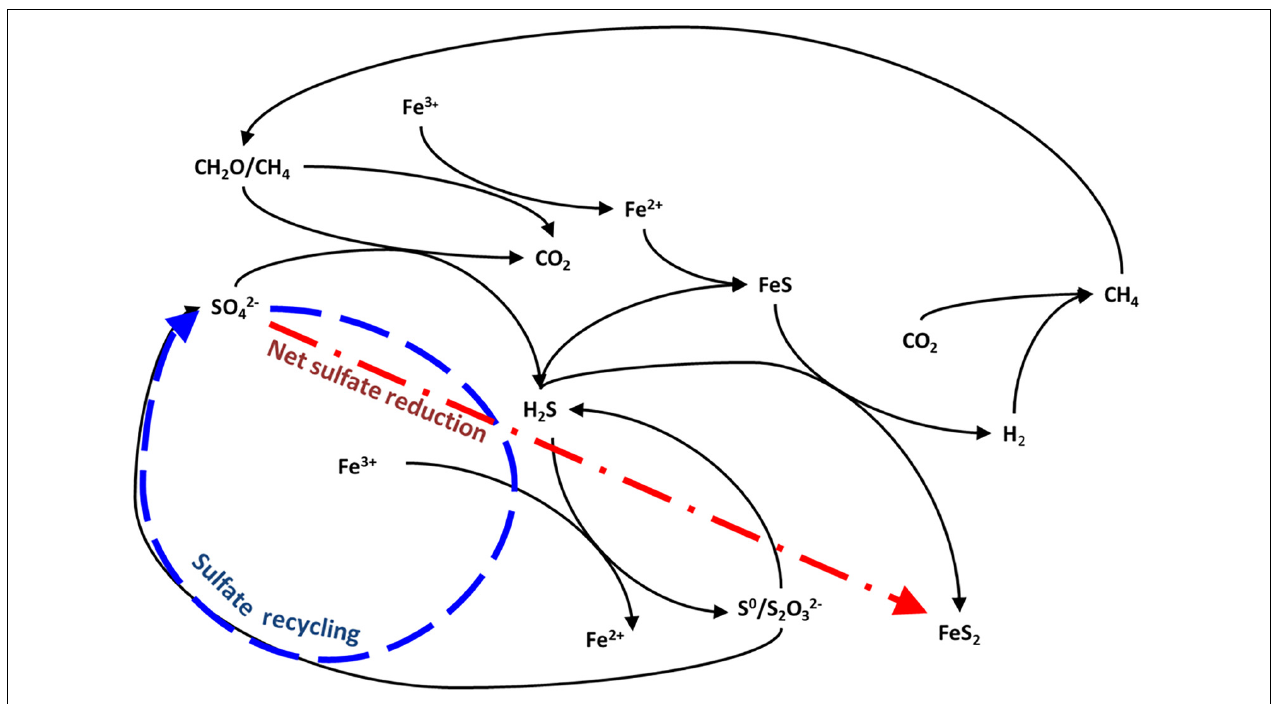
FIGURE 1 | Possible pathways for carbon-sulfur-iron interaction in anoxic sediments after Aller et al. (2010) and Holmkvist et al. (2011). The arrows represent two possible fates for sulfide: burial as pyrite, and reoxidation to sulfate.